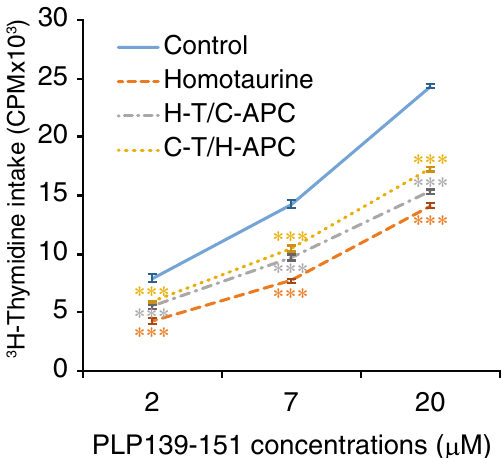
Figure 4. Homotaurine impairs the functions of splenic APCs. SJL mice were immunized with PLP 139-151 and treated with, or without, homotaurine (0.25 mg/ml). Nine days later, CD4 + T cells were purified from their popliteal lymph nodes and T cell-depleted splenic mononuclear cells (APCs) were prepared by negative selection using microbeads and magnetic sorting. The T cells were mixed with APCs in a ratio of 5:1 and tested for T cell proliferation to the indicated concentrations of PLP 139-151 for 3 days by 3 H-thymidine incorporation. “Control” (solid blue line) represents 3 H-thymidine incorporation by T cells and APCs isolated from untreated mice; “Homotaurine” (orange dashed line) shows 3 H-thymidine incorporation by T cells and APCs isolated from homotaurine-treated mice ; “H-T/C-APC” (grey dash/dotted line): T cells were isolated from homotaurine- treated mice and mixed with APCs from control untreated mice. “C-T/H-APC” (yellow dotted line): T cells were isolated from control mice and mixed with APCs from homotaurine-treated mice. Data are expressed as the mean values of each group ± SEM. The control cells without peptide stimulation had a CPM of 600–800 and the intra-group variation was less than 12%. N = six mice per group tested in two separate experiments. ***p < 0.001 vs. control by Student’s